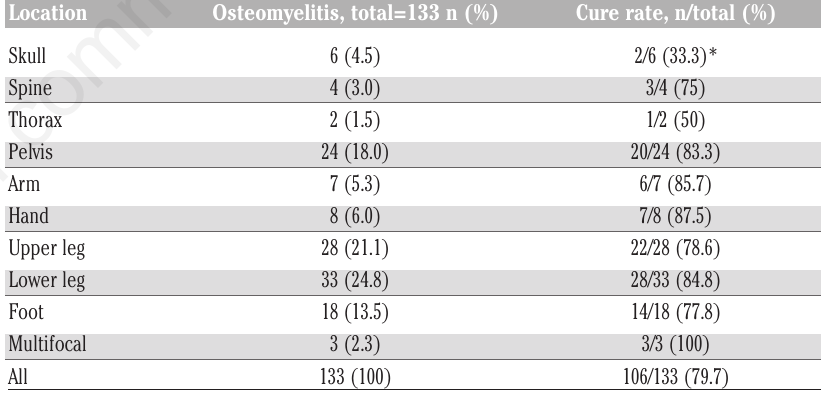
Table 2. Location of osteomyelitis and cure.